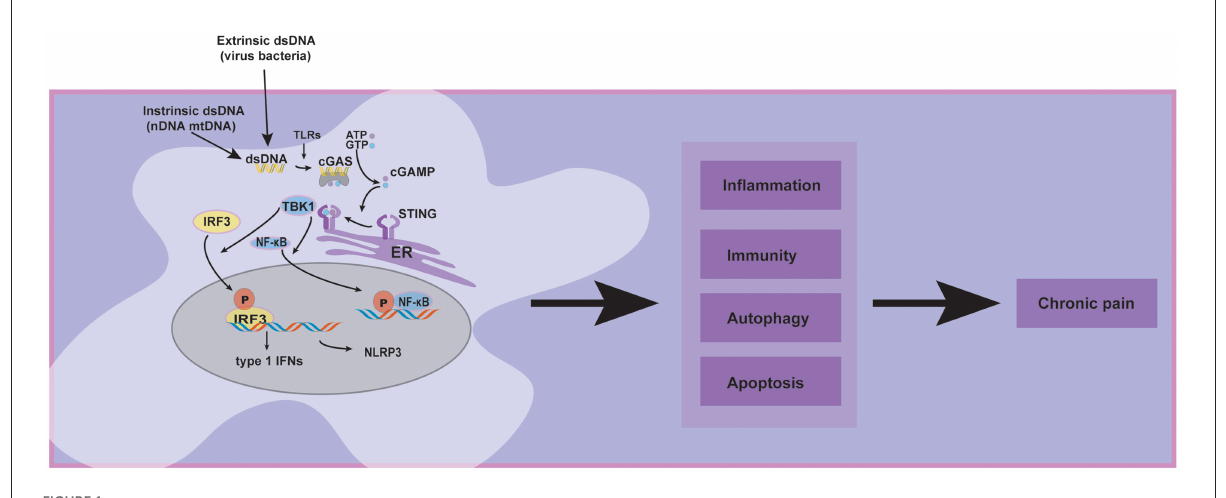
FIGURE1 The diversity of cGAS-STING pathway activation in chronic pain and its related